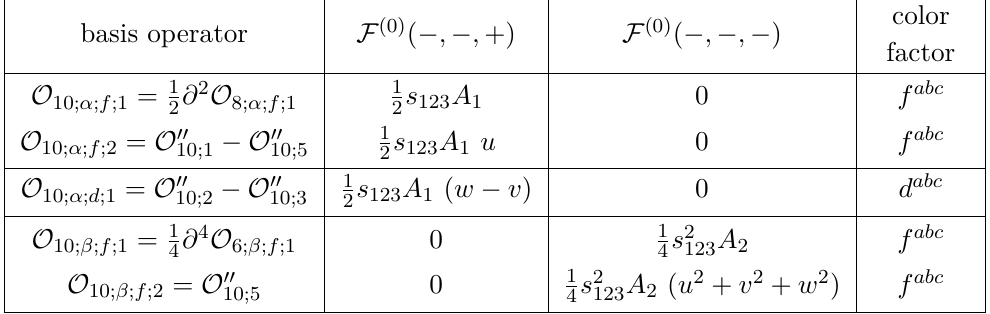
Table 13 . Final basis operators at dimension 10.